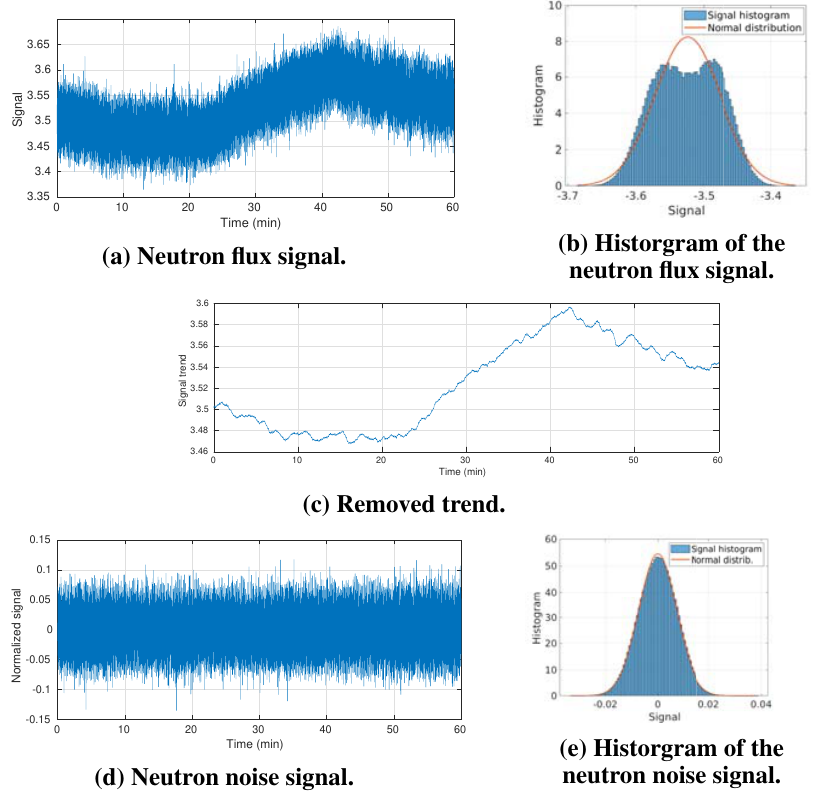
Figure 2: Detector 3 (experiment 12): Signal